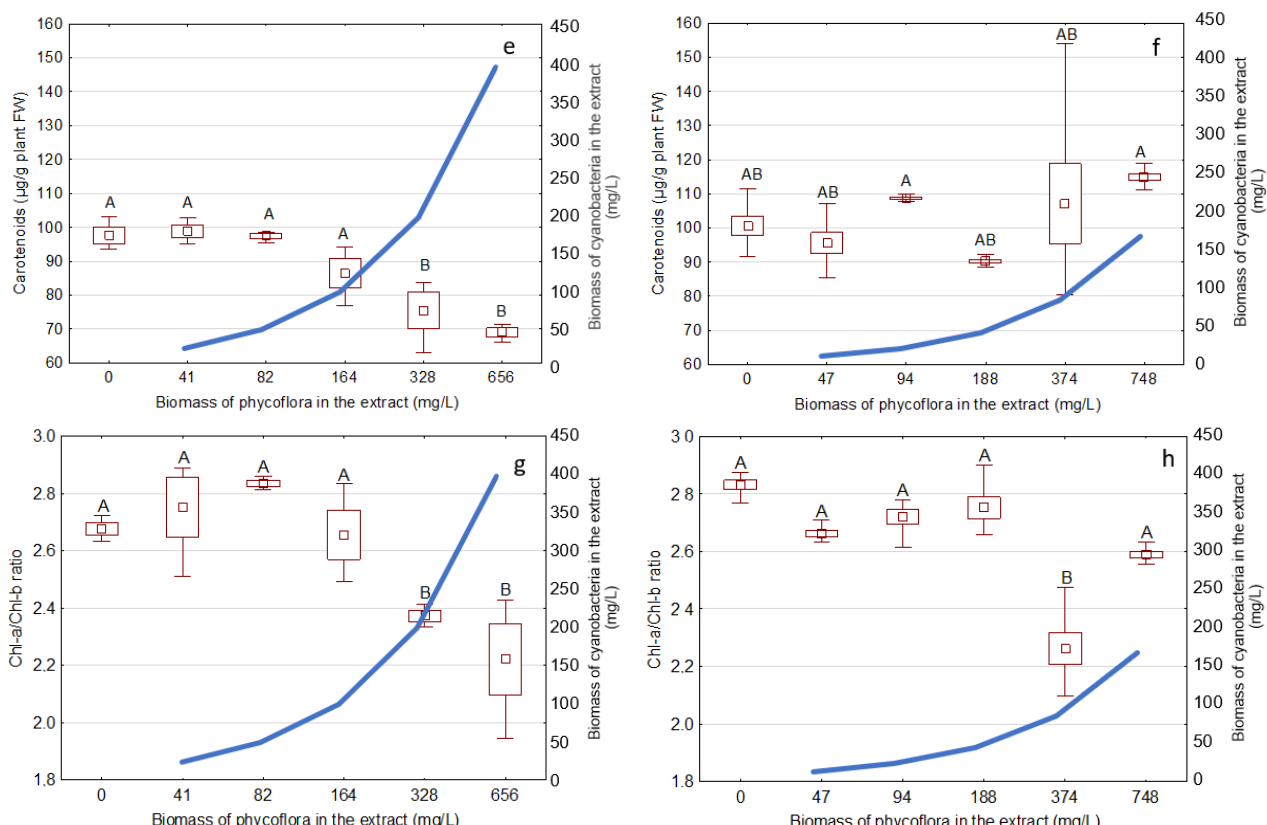
Figure 4. Content of Chlorophyll-a (Chl-a; ( a , b )), Chl-b ( c , d ), carotenoids (Car, ( e , f )), and the ratio of Chl-a to Chl-b ( g , h ) in S. polyrhiza exposed for 72 h to Phormidium extract ( a , c , e , g ) and Oscillatoria extract ( b , d , f , h ) (means ± SE, n = 3, 0 = controls). Different uppercase letters (A, B, C) indicate statistically significant differences between treatments (ANOVA, Tukey’s test, p < 0.05).